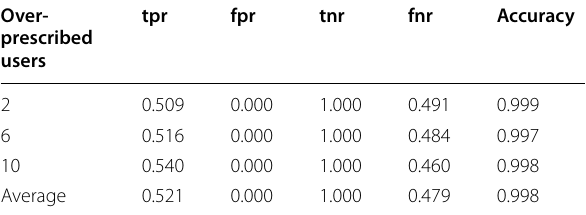
Table 4 Average accuracy values by number of over-prescribed users Over-